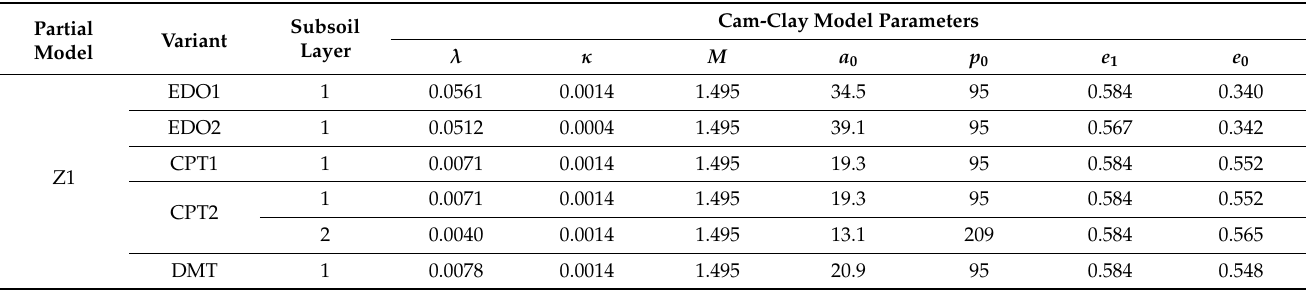
Table 4. A compilation of the parameters of the Modified Cam-Clay model for partial